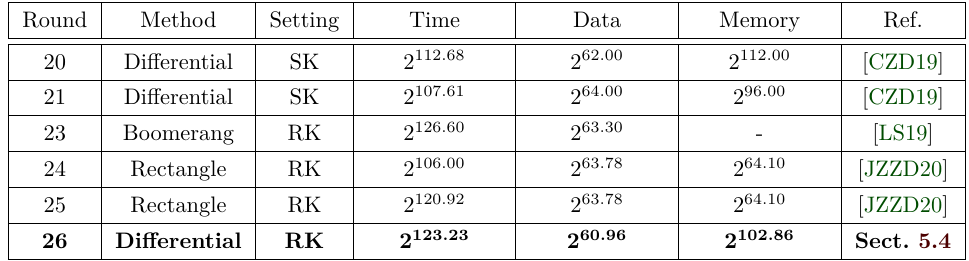
Table 2: Symmary of cryptanalytic results on GIFT-64